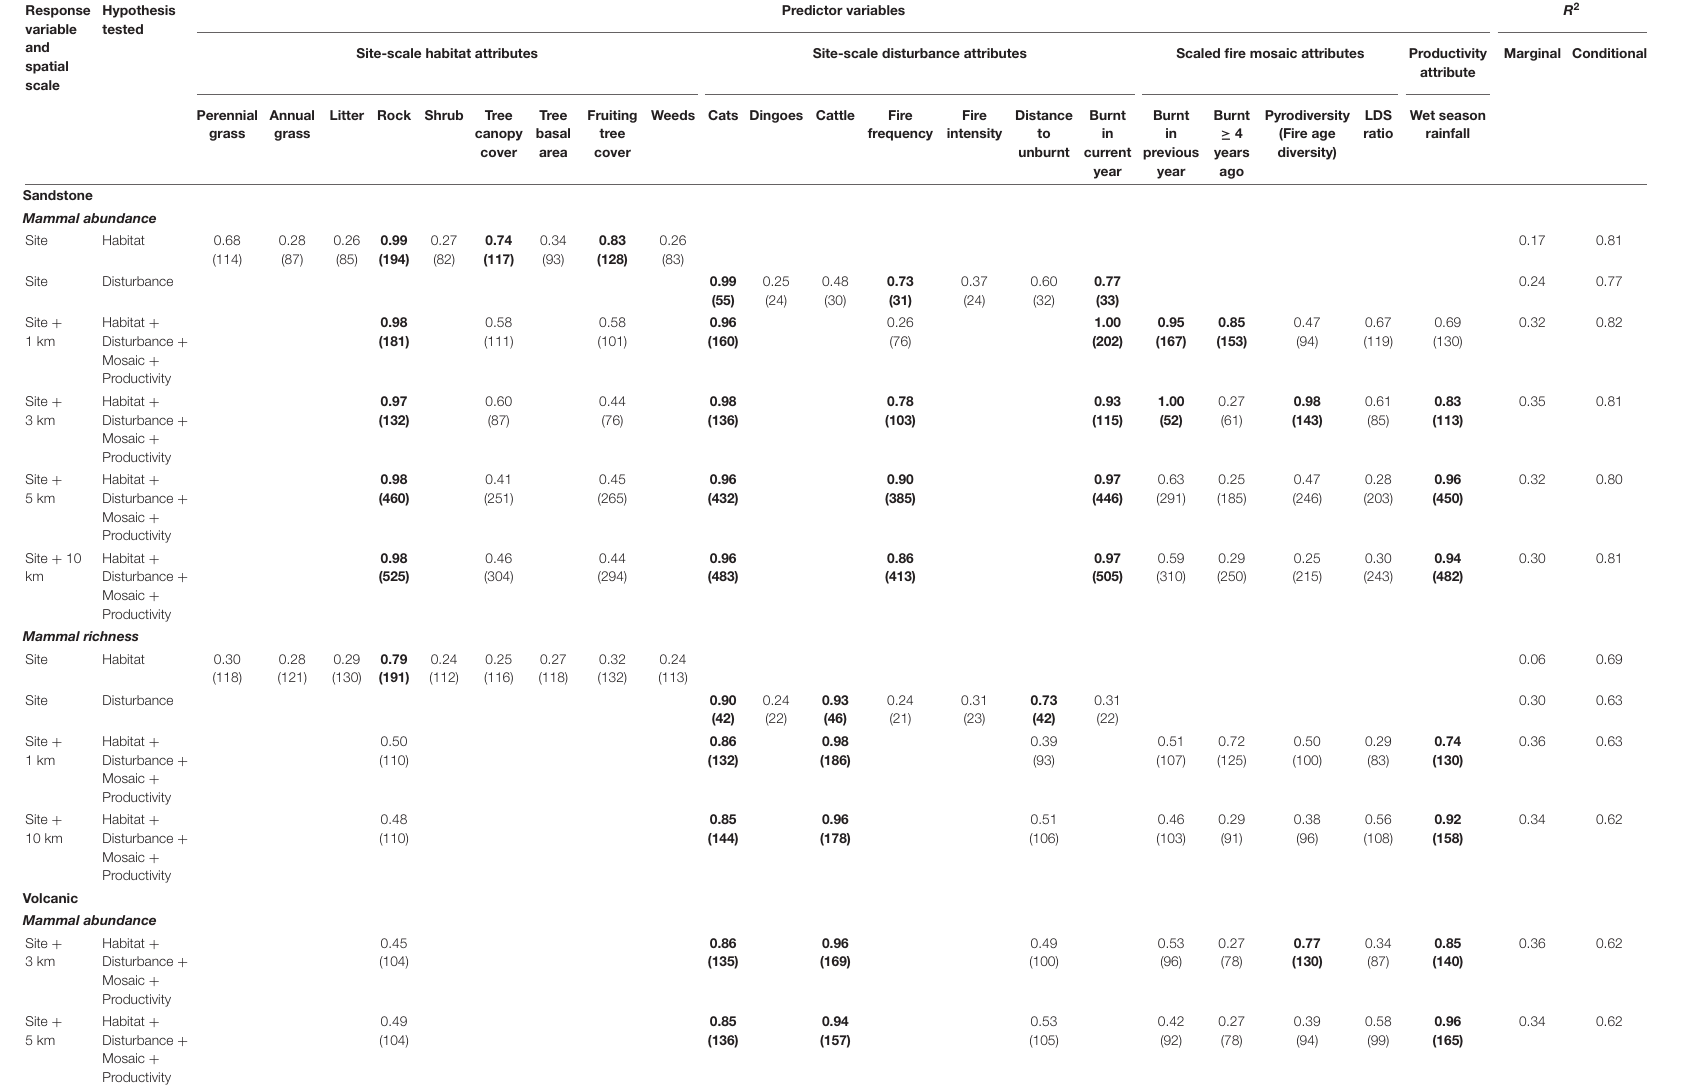
TABLE 3 | The relative importance of habitat, disturbance, pyrodiversity, and productivity variables derived from general linear mixed models (GLMM) modeling the effect of these variables on mammal abundance or richness. Response